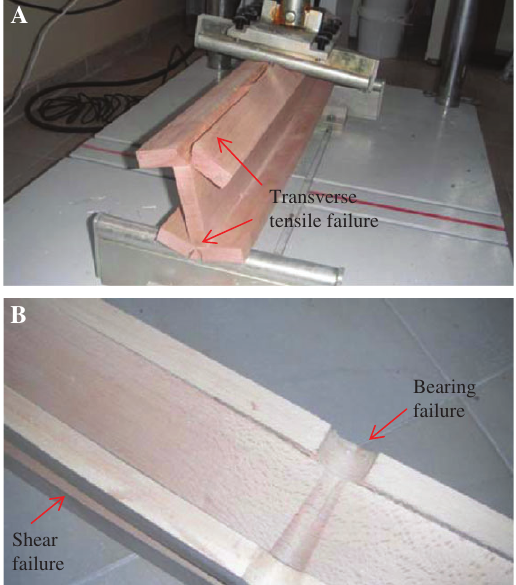
value. Figure 8 A shows total beam failure resulting from flange failure for the Group A specimen with I-shaped cross section. The red arrows indicate the locations of the failure observed in the beam. As visualized, the bottom and top flange of the beam failed while the web remained stable. This failure occurred because of two reasons: (i) relatively higher moment of inertia of Group A specimen with square hollow cross section.